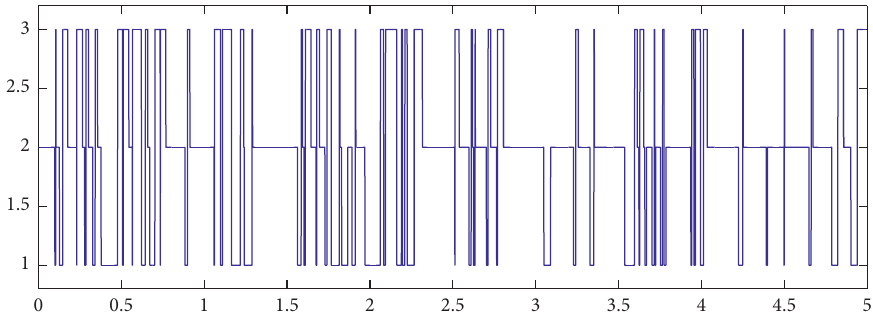
Figure 1: Computer simulation of a single path of ς ( t ) with initial value ς ( 0 ) � 2.